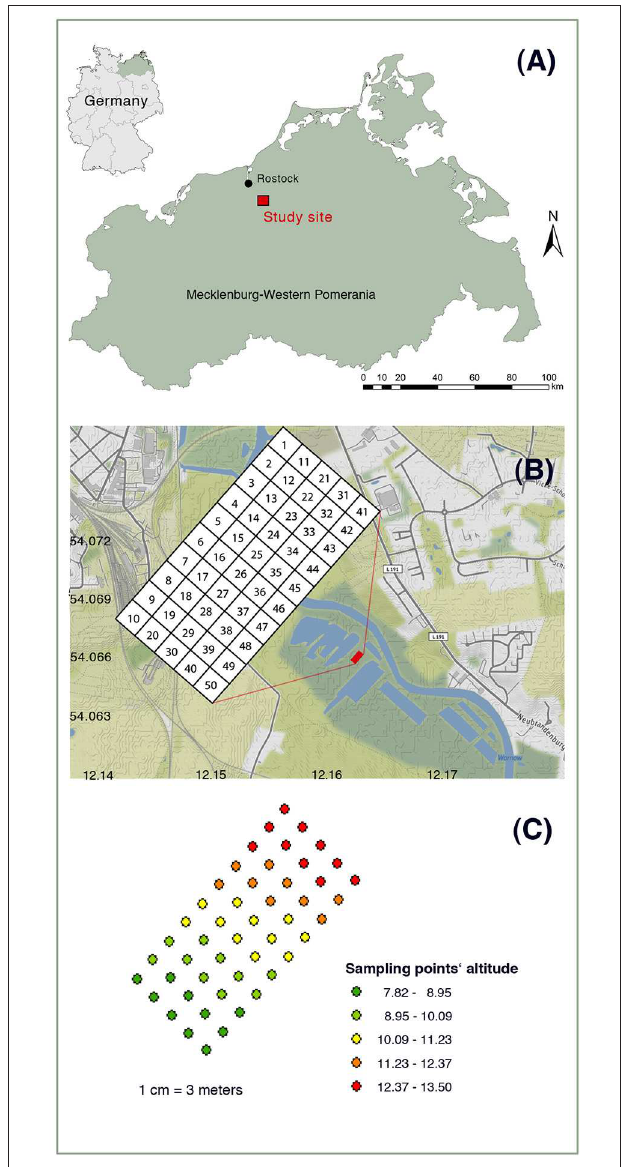
FIGURE 1 | Location of the study site (A) , plot arrangement (B) , and elevations (C) of peat sampling